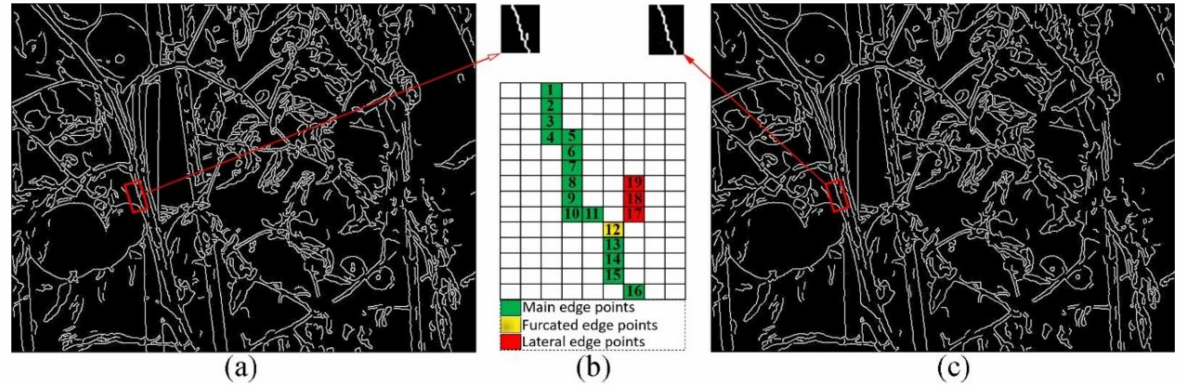
Figure A3. Principle of the sorting algorithm: ( a ) Canny edges; ( b ) sorting principle; ( c ) sorted